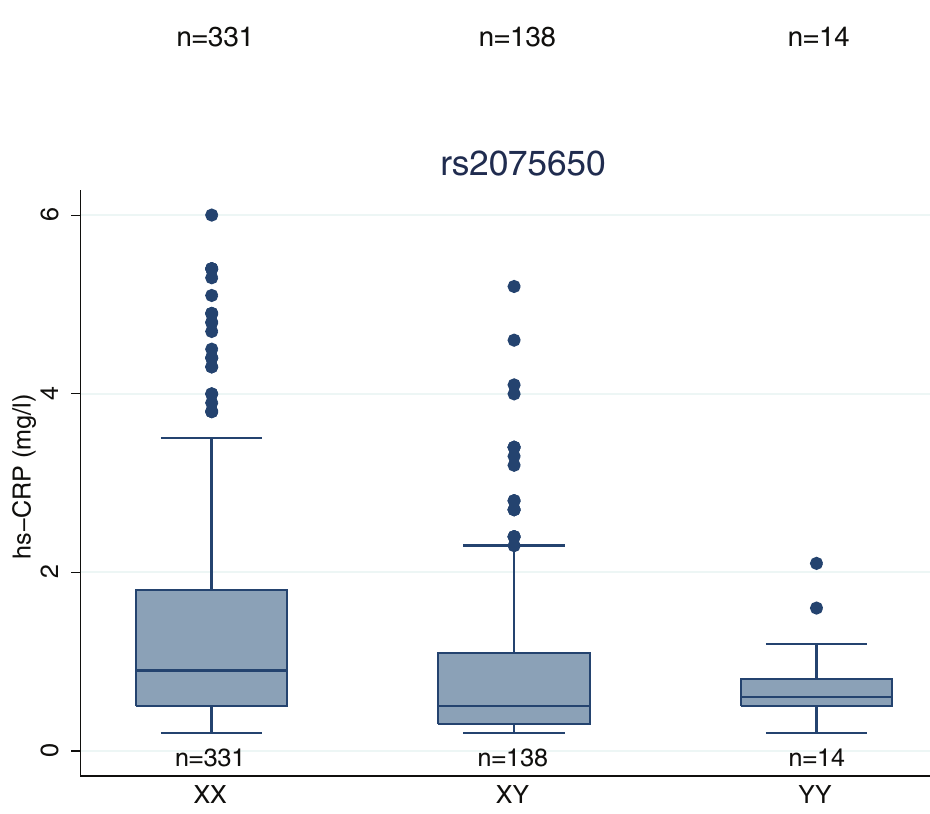
Fig 2. Distribution of hs-CRP levels stratified by the genotypes of rs2075650. Boxes and whiskers indicatequartilesand adjacent values. Values outsidethe range of adjacentvalues are plotted as outliers. Abbreviations: hs-CRP, high sensitivity